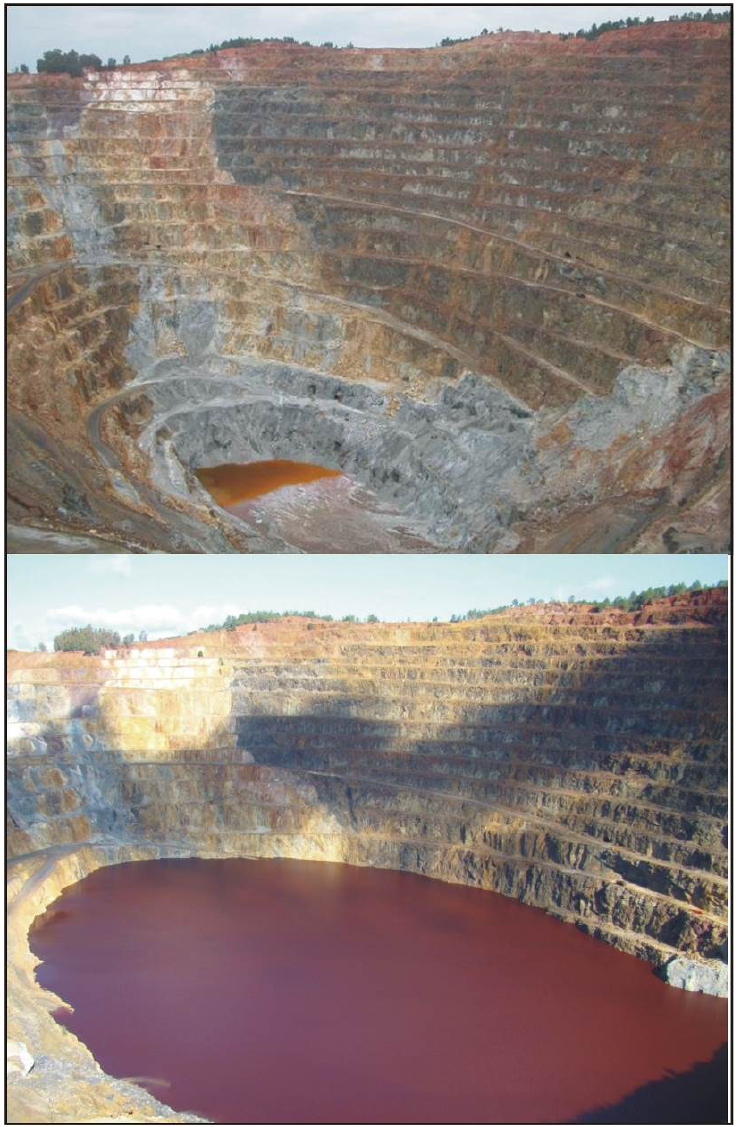
Figure 9. Atalaya open-pit before cessation of drainage pumpings in 2001 (up) and in 2014